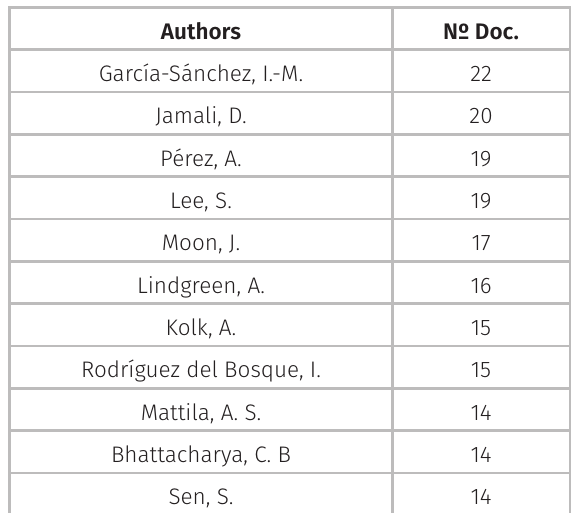
Table I. Production of the authors in